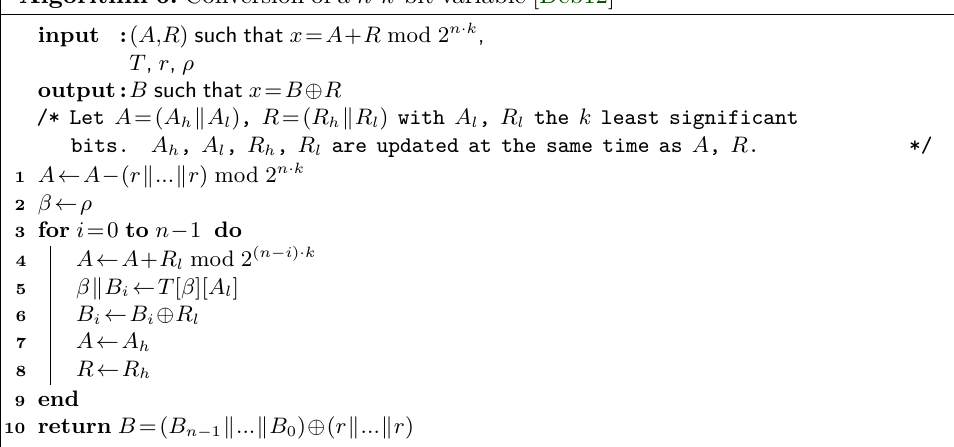
Algorithm 6: Conversion of a n · k -bit variable